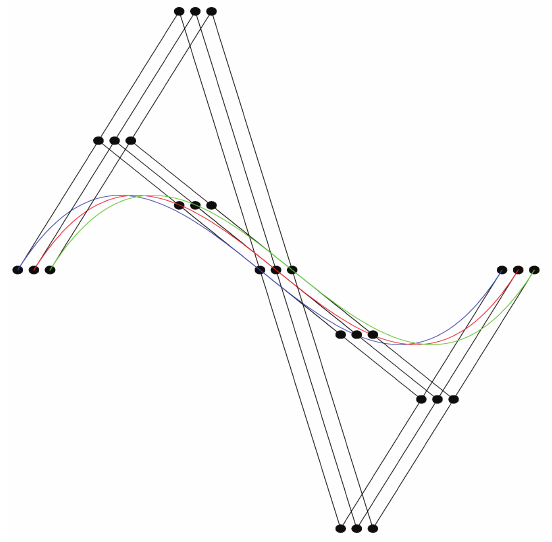
Figure 3. Fuzzy cubic B.B cuve.